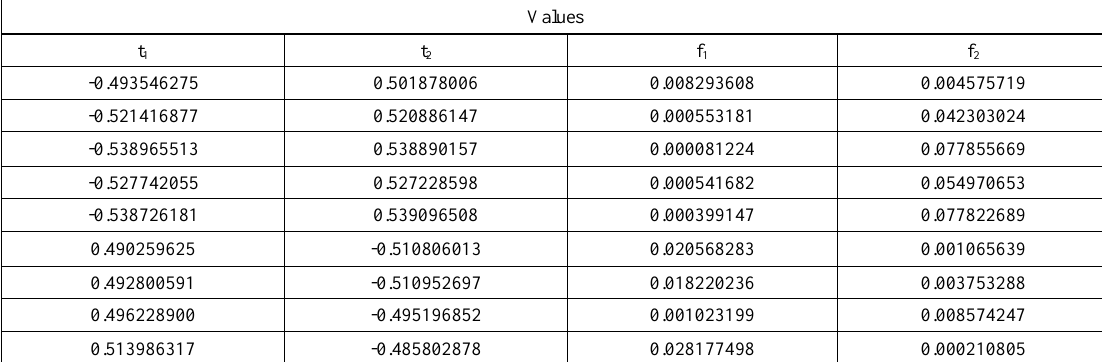
Table 5. Pareto front obtained by MOPSO for Problem 3